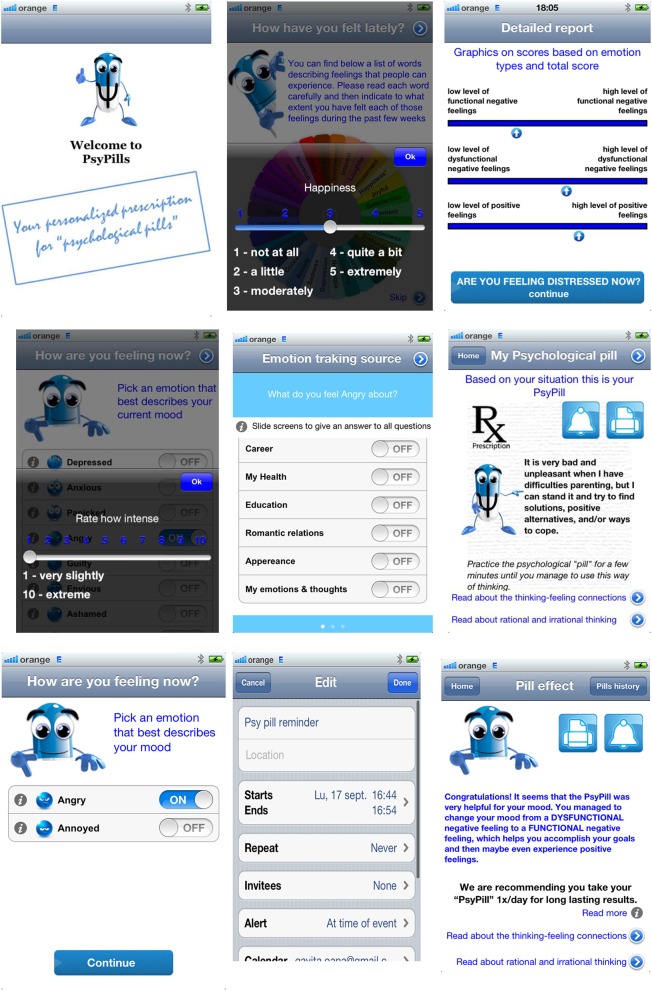
The ABC model of REBT and the main irrational and rational processes. Sequence of the screens in the PsyPills app.